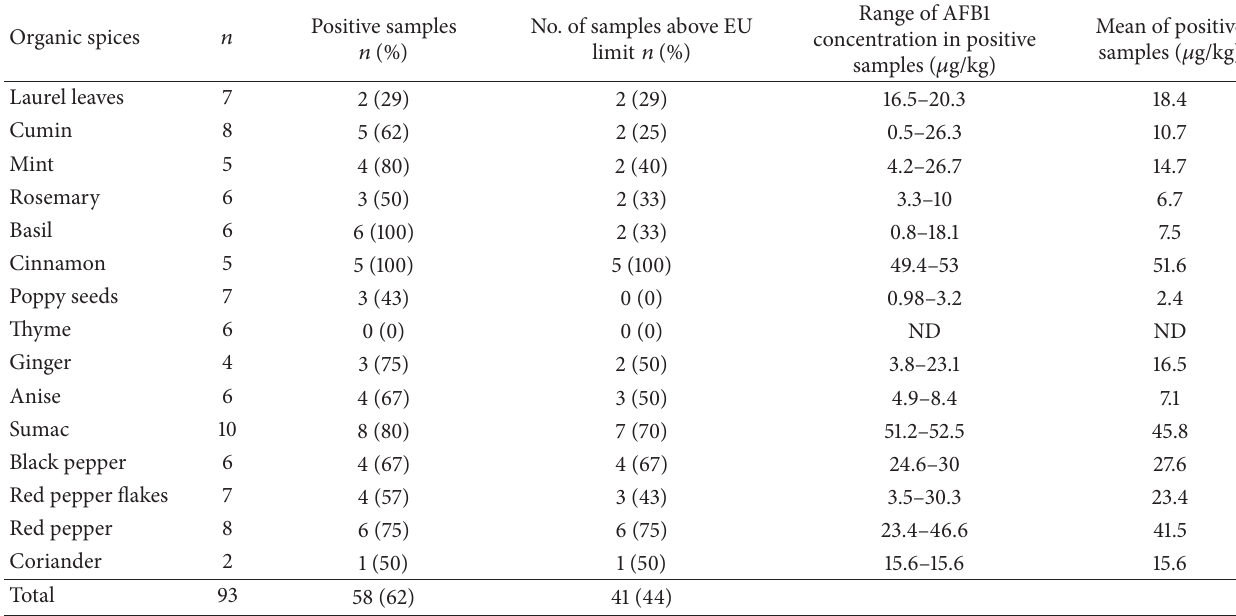
Table 1: Aflatoxin B1 content of organic spice